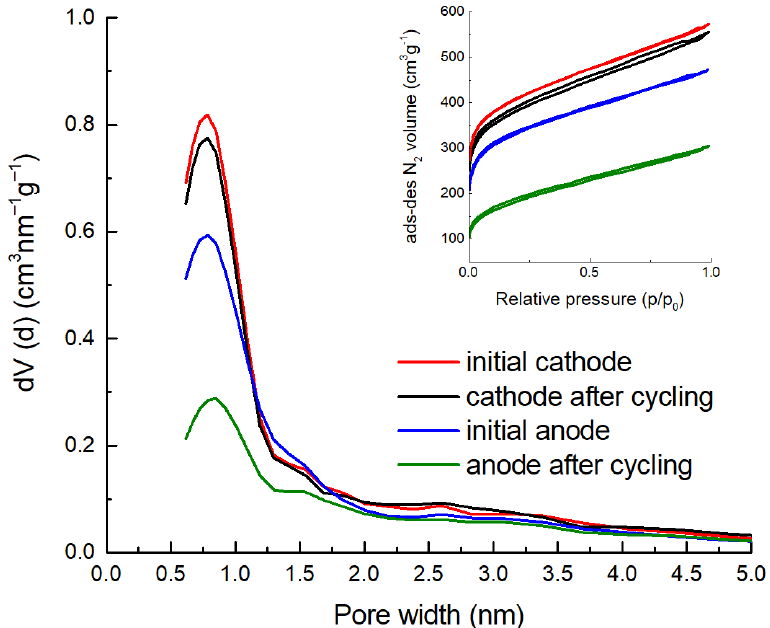
Figure 4. Pore size distribution of cathode and anode before and after cycling calculated per weight of CDC from N 2 isotherms (inset).